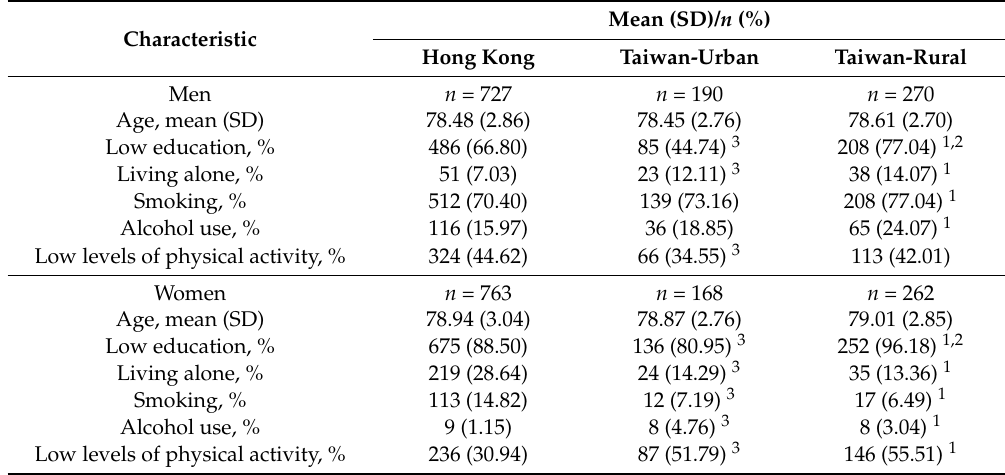
Table A3. Population characteristics between Hong Kong, Taiwan-urban and Taiwan-rural: age